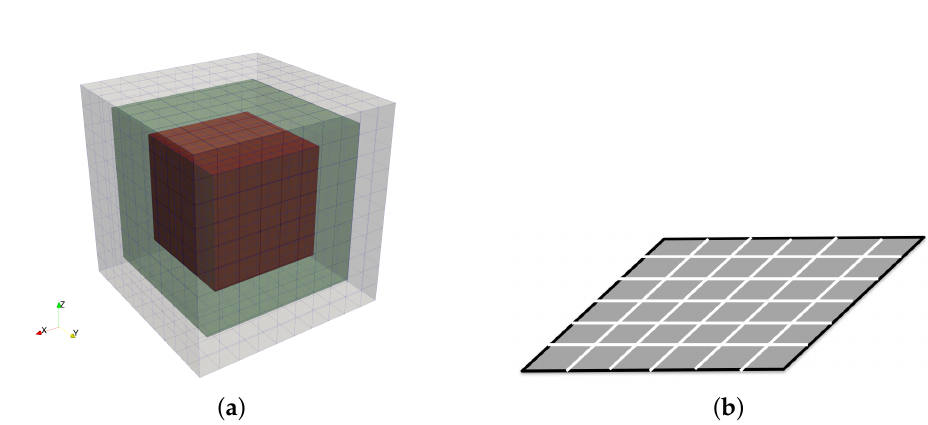
Figure 2. Three-layered MSR mesh ( a ). Detail of the layer surface discretization ( b